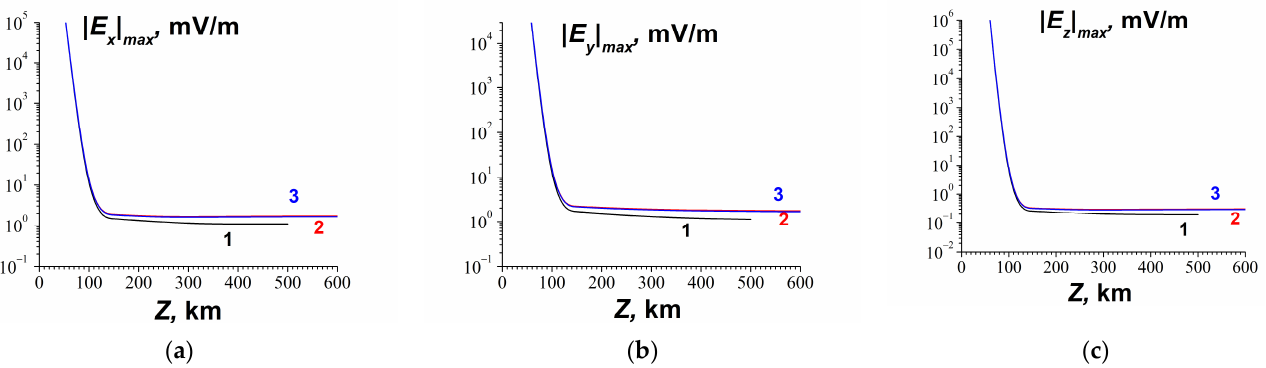
Figure 5. The dependencies of the maximum values of the electric field components E x ( a ), E y ( b ) and E z ( c ) on the vertical coordinate obtained in the dynamic simulations, the frequency is ω = 0.025 s − 1 , Curve 1 is for L z = 500 km, 2 is for L z = 1000 km, 3 is for L z = 1500 km. The geomagnetic field inclination is θ i = 10°. The case of open geomagnetic field lines is considered. Leaving empty space in the lower atmosphere area in Figure 5a–c and below in Figures 7, 8 and 13, corresponds to the rejection of claims for an adequate definition of the electric field in the external current region, introduced instead of an synergetic self-consistent definition of current and field, as explained in detail in the introduction to this work, as well as in [15].